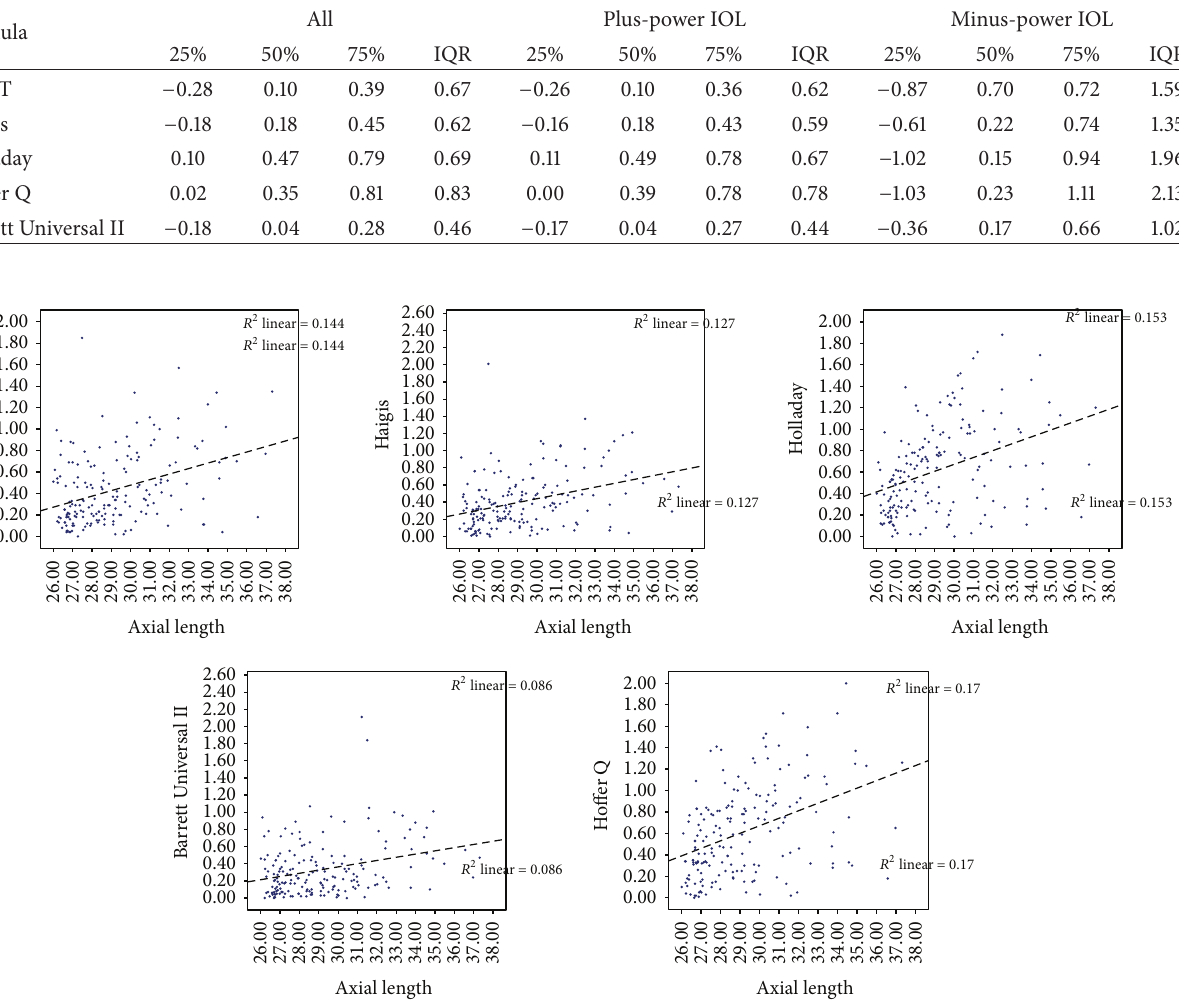
Figure 2: The association between absolute prediction error and axial length. 𝑥 axis was axial length; 𝑦 axis was absolute prediction error of each formula. The refractive errors were higher as the axial length became longer for all formulas.